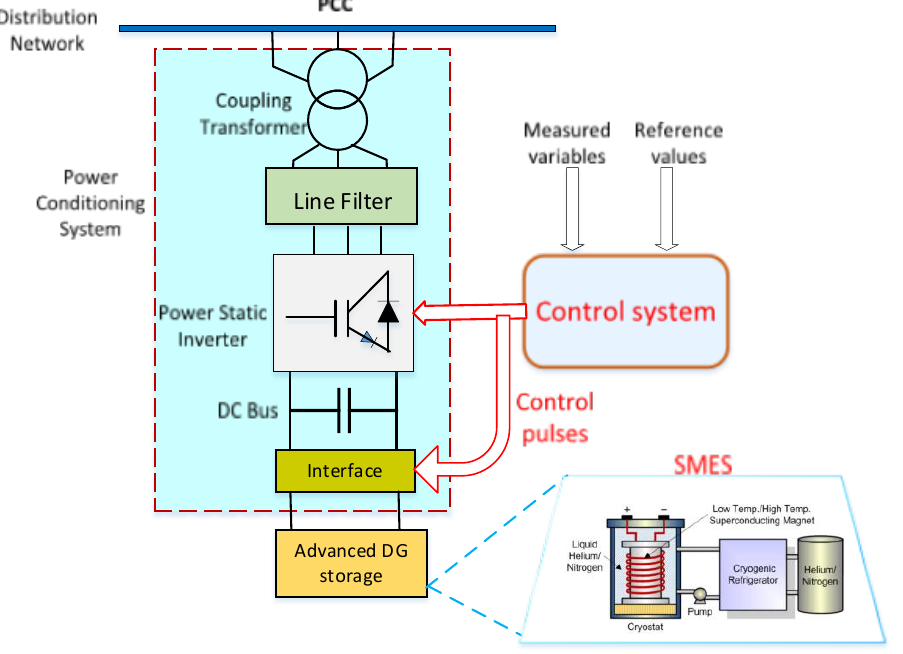
Figure 6. Schematic block diagram of the SMES device. Table 3. Comparison between SMES devices and batteries in power system applications.